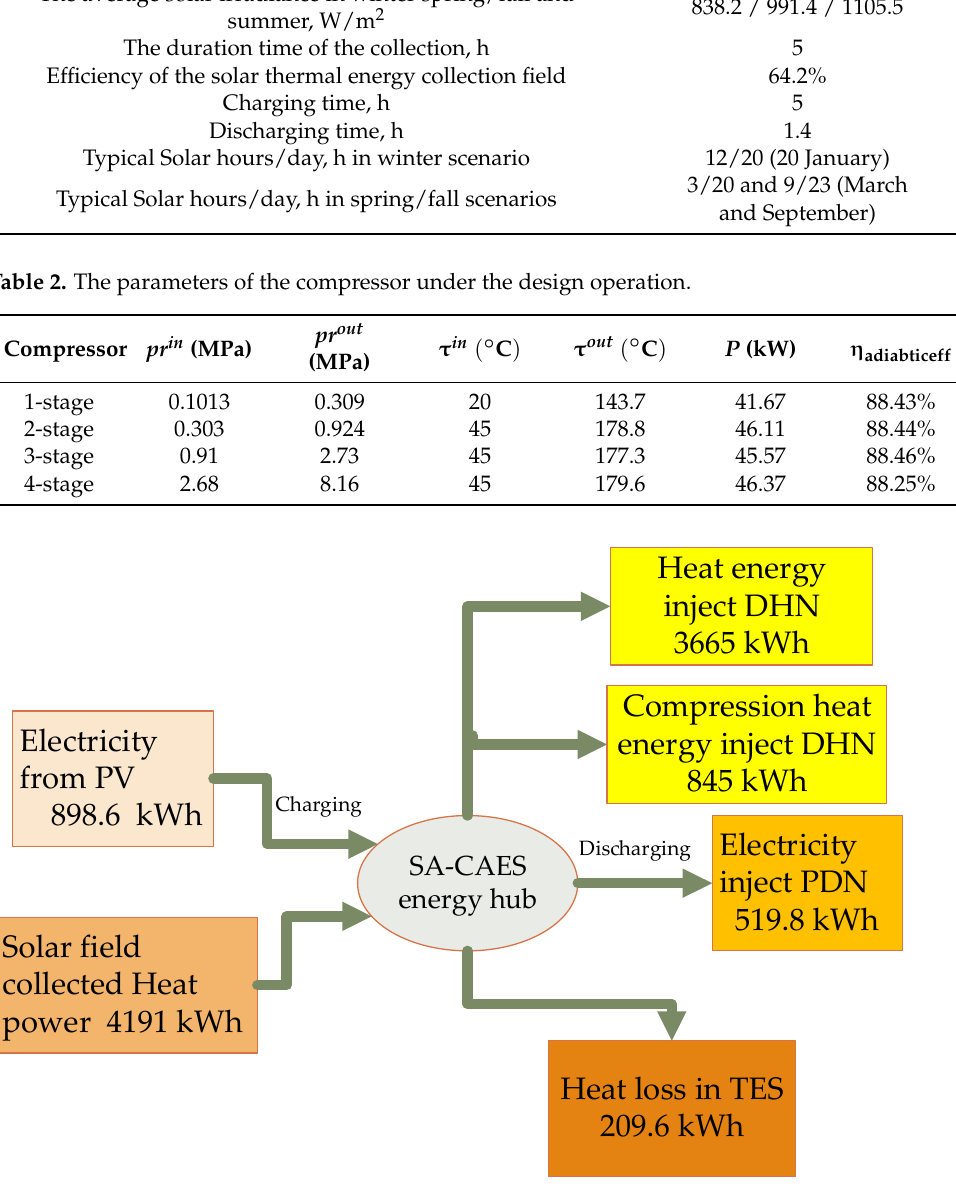
Figure 5. Energy flow of the designed 400 kW SA-CAES. Table 1. The designed parameters of the SA-CAES system.